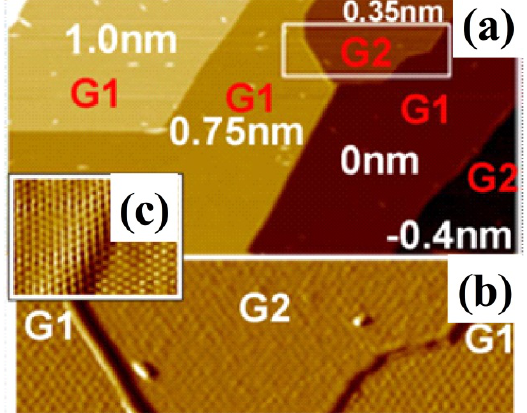
Figure 1. ( a ) 250 × 250 nm 2 area scanning tunneling microscopy (STM) image showing different heights on a graphitized 6H-SiC(0001) sample; ( b ) The outlined white box of Figure 1a. All step heights can be written in terms of s = 0.25 nm or g = 0.35 nm; ( c ) Single layer graphene growing uninterrupted over a graphene